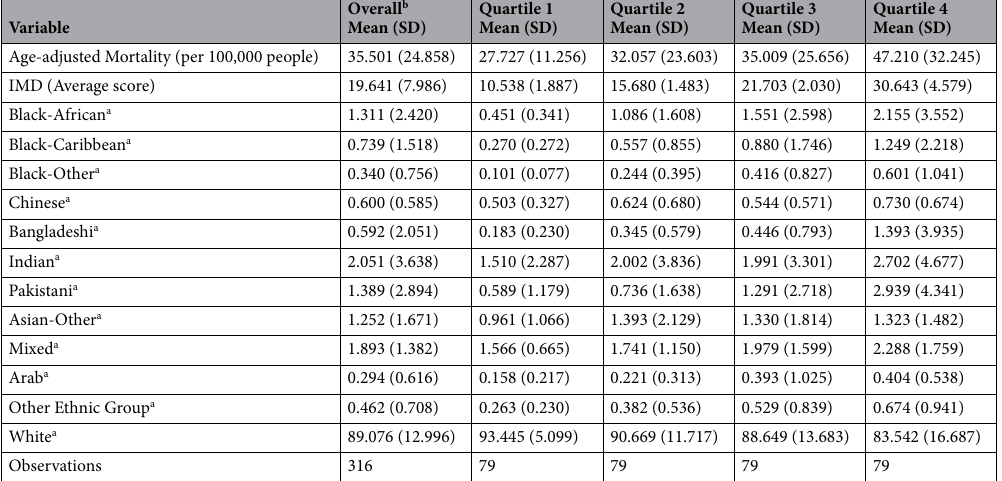
Table 1. Characteristics of LADs: summary statistics. Quartile 1–4 denotes the quartiles based on index of multiple deprivation. Quartile 1 is least deprived and Quartile 4 is the most deprived. a Denotes in terms of percentage of total population in the LAD. b Overall indicates for the whole of